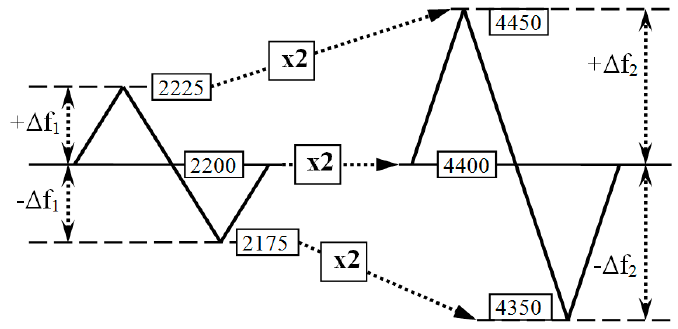
Figure 6. Principle of radio altimeter with extreme bandwidth.